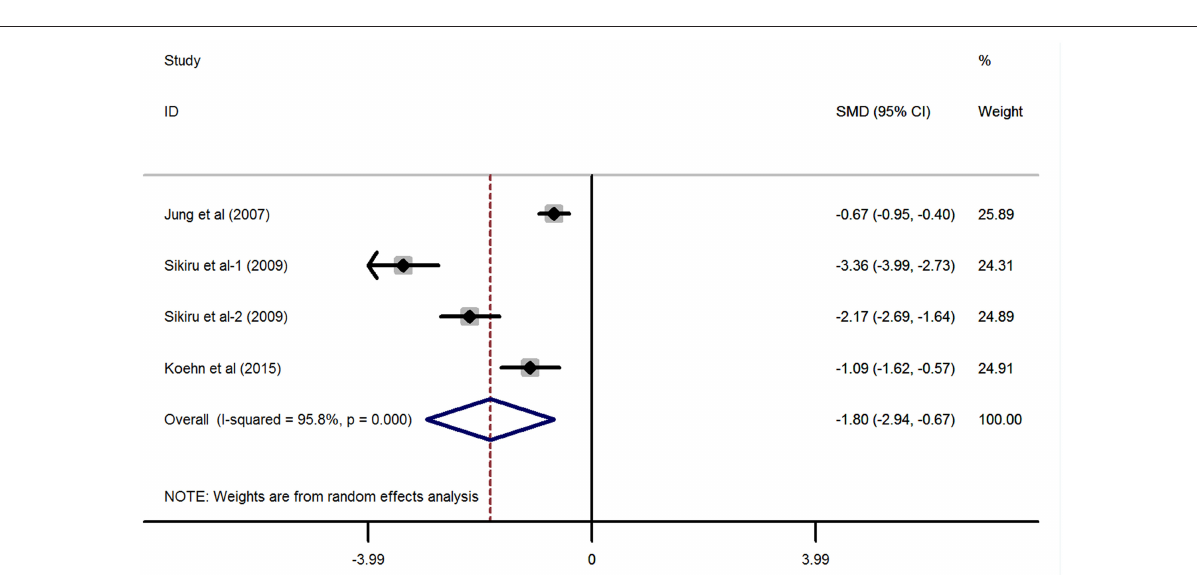
may induce a disruption in central autonomic network structures and pathways that contribute to the erection (10). In addition, it was suggested that autonomic system dysfunction after stroke may contribute to sexual impairment in the affected patients. Of note, different stroke lesions may result in varying frequencies and severities of ED. For example, Koehn et al. (26) indicated that patients with cerebellum stroke suffered less frequent ED (40%) than those with other stroke locations, i.e., middle cerebral artery territory (MCA, 78.8%), brain stem (80%), and posterior cerebral artery territory (80%). It was suggested that stroke lesions in the